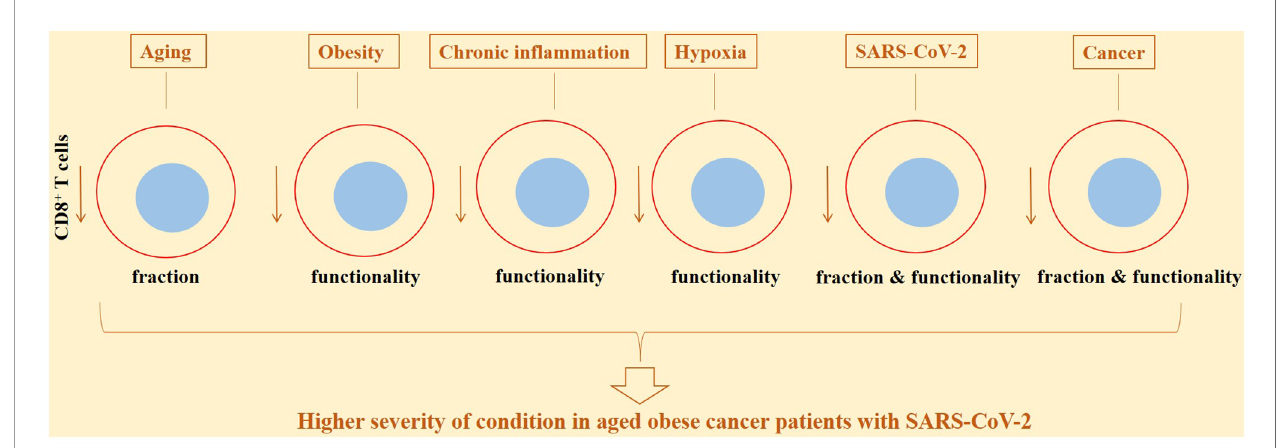
FIGURE 6 | CD8 + T-cell diverse functionality and fraction in response to different conditions, in cancer patients and in cases with active SARS-CoV-2. The activity and fraction of CD8 + T cells are in fl uenced from several conditions. Aging, obesity, chronic in fl ammation, and hypoxia are among the most important contributors in this context, rendering lower responses to anticancer therapies or reducing the ef fi cacy of vaccination against